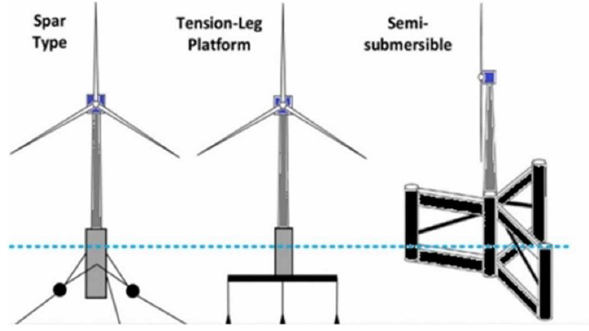
Figure 6. Spar-TLP-semisubmersible wind-wave devices.